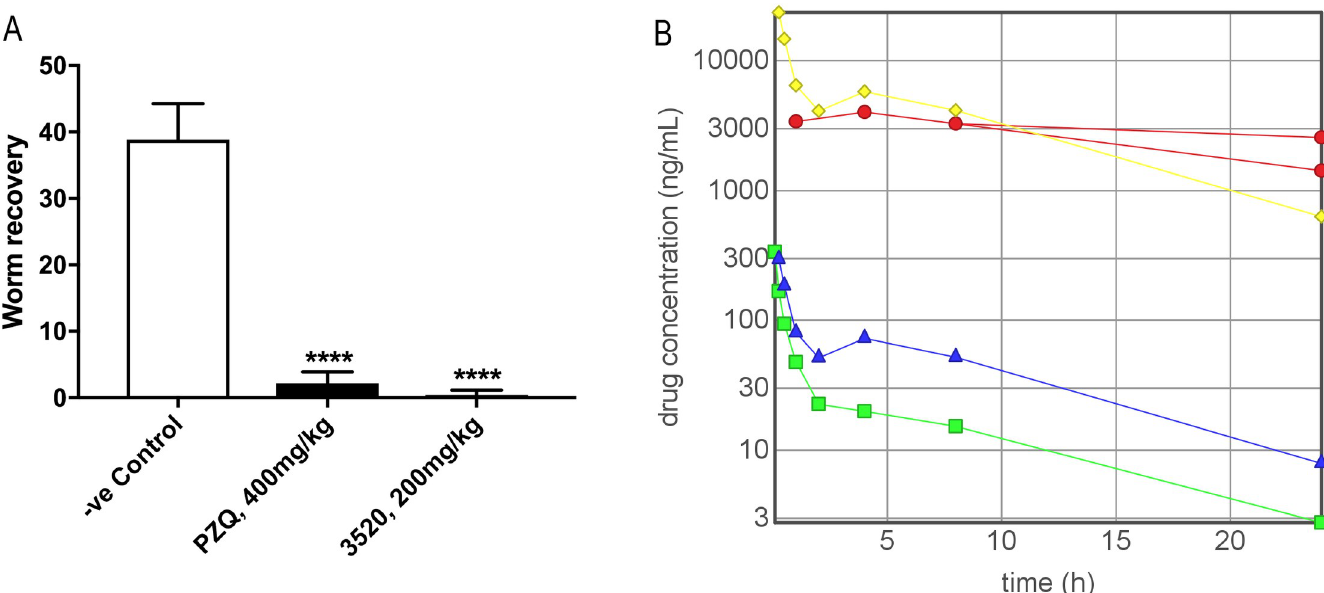
Fig 6. A. In vivo efficacy against adult worms in the mouse model. Graph shows the Mean (+standard deviation) worm recoveries following single oral dose treatment with vehicle or vehicle plus LSHTM-3520 (Aqueous formulation- see Materials and Methods) of 42-day old infections in mice (n = 6). B. Drug concentration in plasma measured at different time points after administration. Green rectangle—PK experiment, iv dose of LSHTM-3520 0.5 mg/kg co-administered with 4 other compounds, data points are mean values from 3 mice. Purple triangle—PK experiment, oral dose of LSHTM-3520 2.5 mg/kg co-administered with 4 other compounds, data points are mean values from 3 mice. Red circle—Efficacy experiment, oral dose of LSHTM-3520 200 mg/kg, data points are single values from five different mice each sampled once during the experiment (2 mice sampled at 24 h). Yellow diamond—Arithmetic scaling of the oral dose 2.5 mg/kg cassette dose experiment to simulate a dose of 200 mg/kg to show comparison with experimental measurements of 200 mg/kg oral